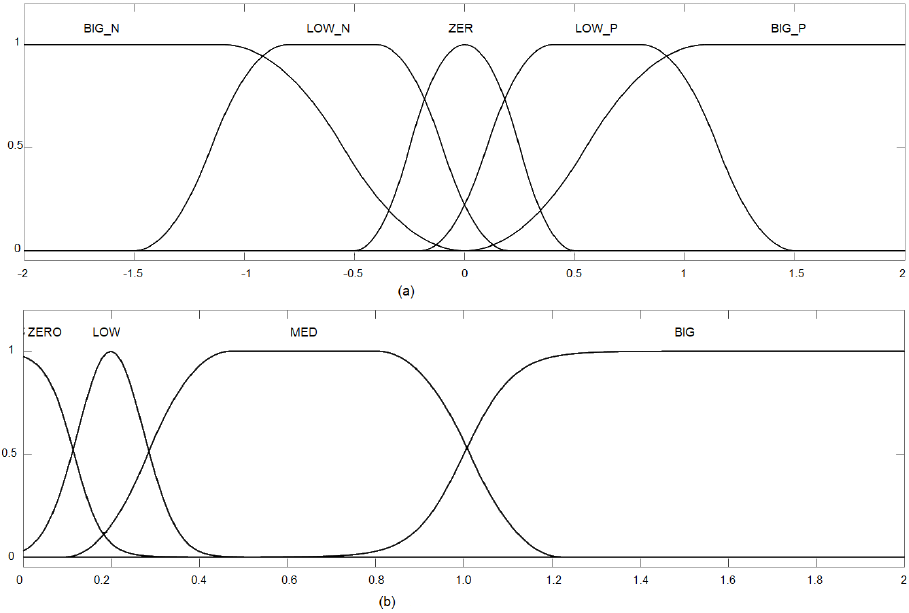
Figure 6. Input fuzzification: ( a ) Altitude error; and ( b ) Derivative of altitude